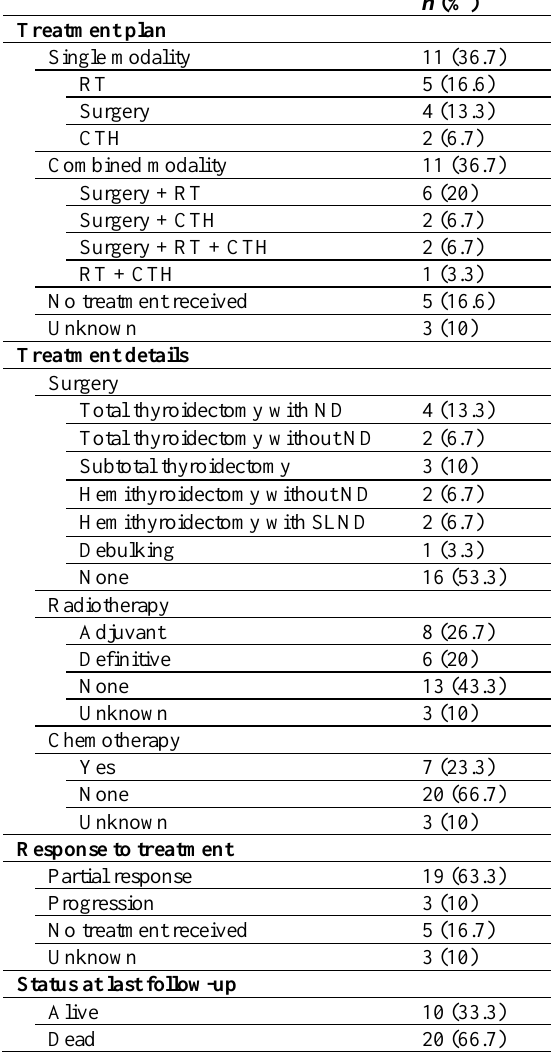
Table 2: Treatment and outcome of 30 patients with anaplastic thyroid